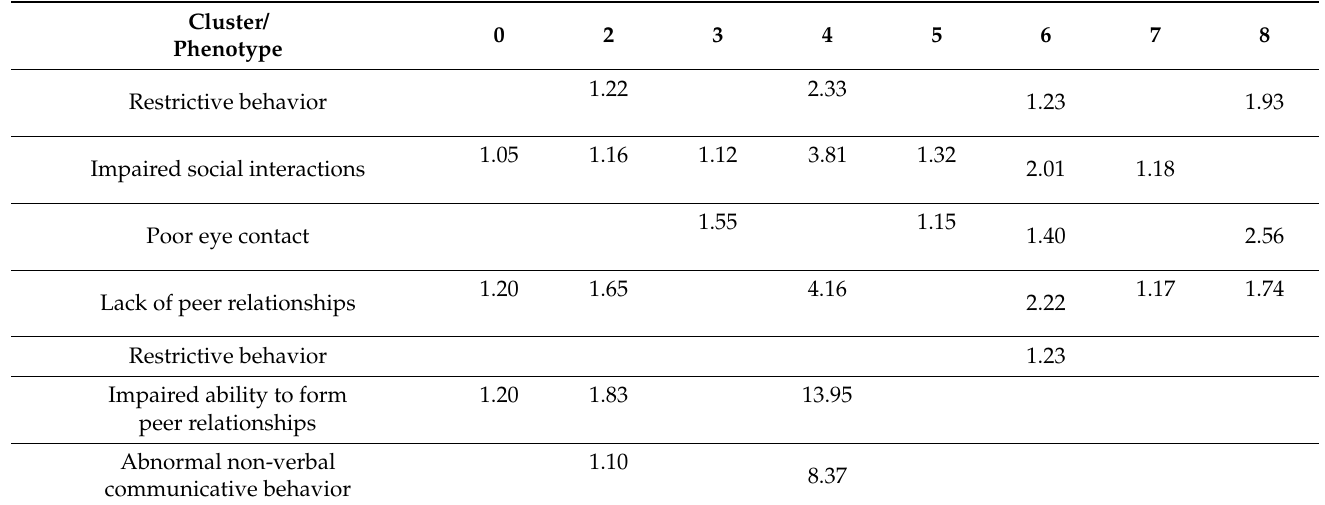
Table 9. Phenotype Fold Enrichment by